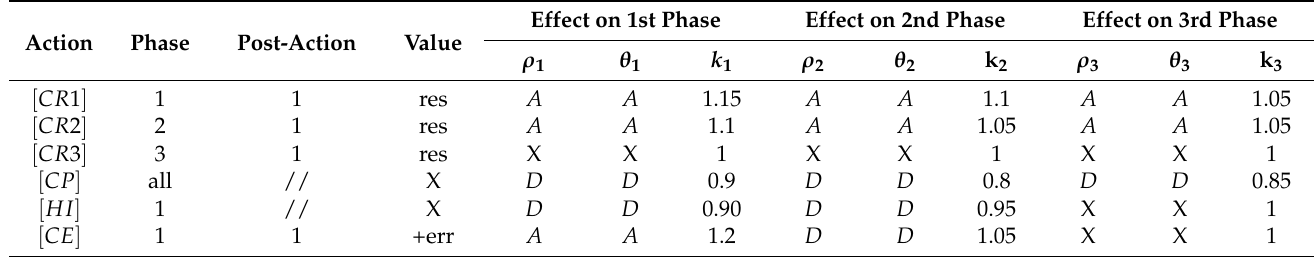
Table 3. The effect of maintenance actions on the degradation